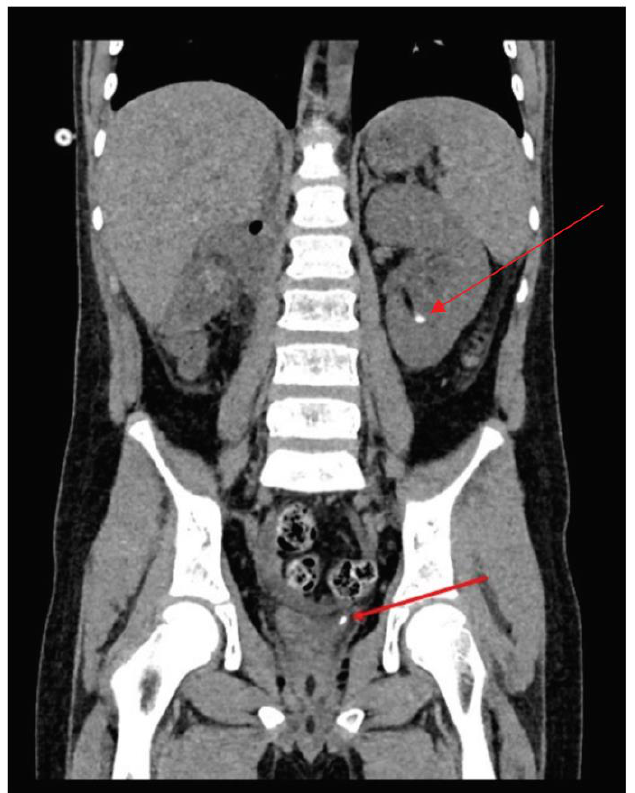
Figure 3. The CT of the abdomen and pelvis with 2 deposits: one within the left ureterovesical junc- tion (lower arrow) and another one within the lower pole of the only preserved renal pelvis (upper arrow).